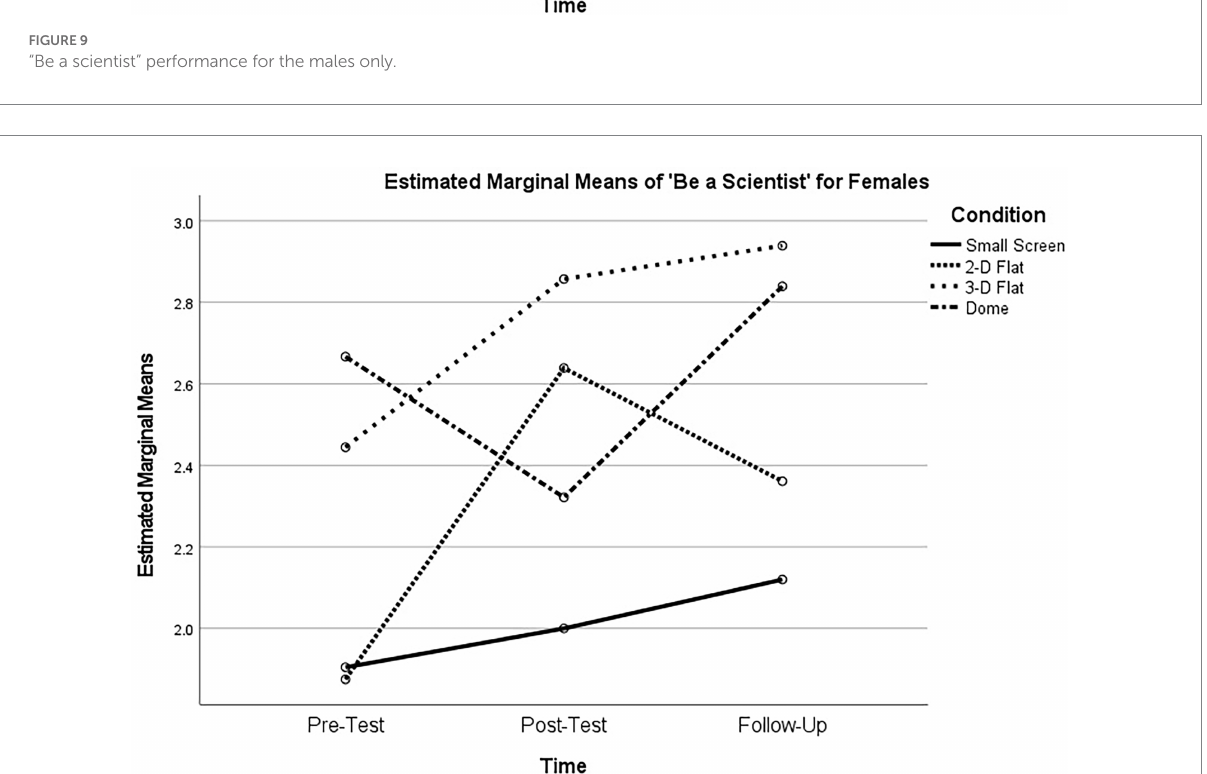
FIGURE 10 “Be a scientist” performance for the females only.